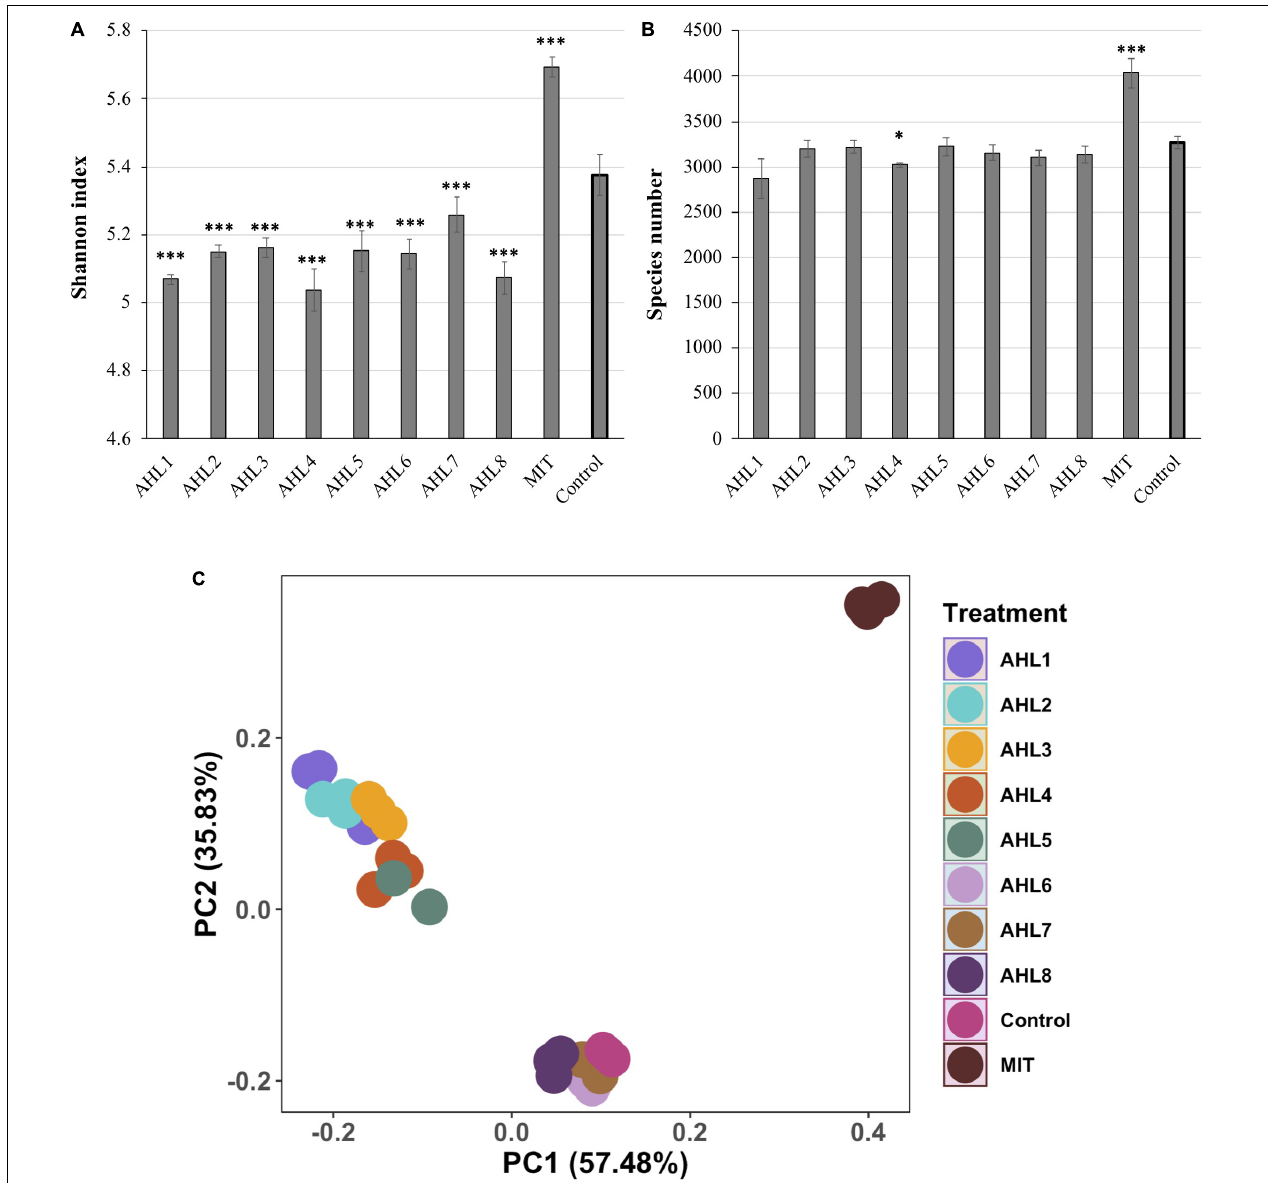
FIGURE 2 | Alpha- and beta- diversity of in vitro bacterial cell suspensions. (A) Shannon index. (B) Bacterial species richness. Data shown as the mean of triplicate cell suspensions assays, and the error bars show one standard deviation. (C) Principal component analysis (PCA) of bacterial community composition. Samples are color-coded based on AHL or mitomycin C (MIT) treatment and the control. AHL1–8 stands for induction using quorum sensing signal molecules of N-(Butyryl, Hexanoyl, β -Ketocaproyl, Heptanoyl, Octanoyl, 3-Oxododecanoyl, Tetradecanoyl, or 3-Oxotetradecanoyl) homoserine lactones, respectively. Statistical significance between the treatment and the control group is indicated by ∗ p < 0.05 and ∗∗∗ p < 0.001.